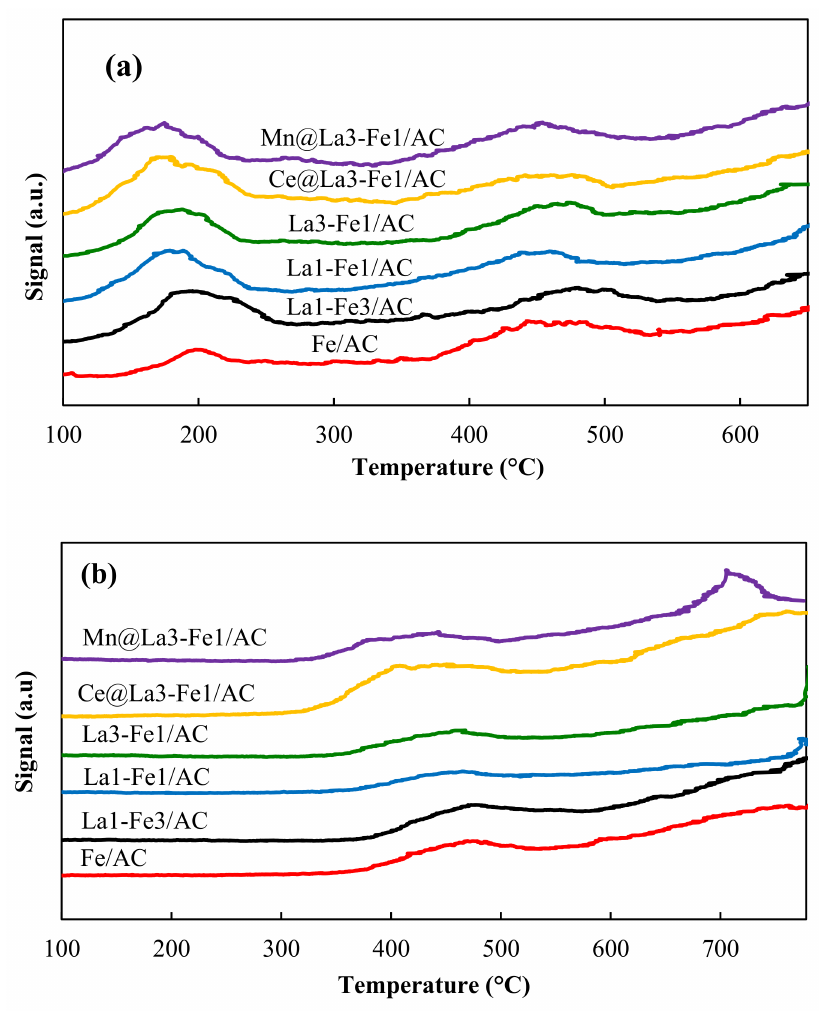
Figure 6. ( a ) NO-TPD and ( b ) CO-TPD profiles of the synthesized